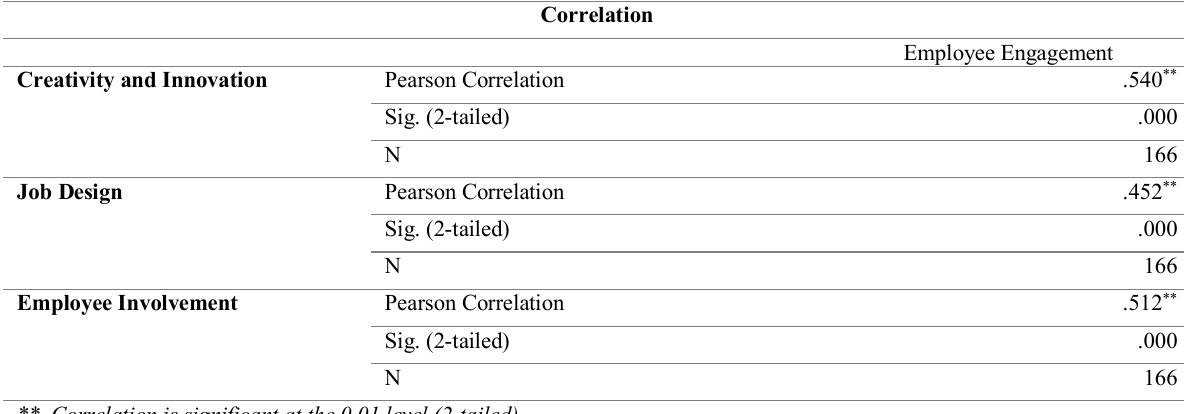
Table 1 : Correlation between Intellectual Stimulation and Employee Engagement Correlation